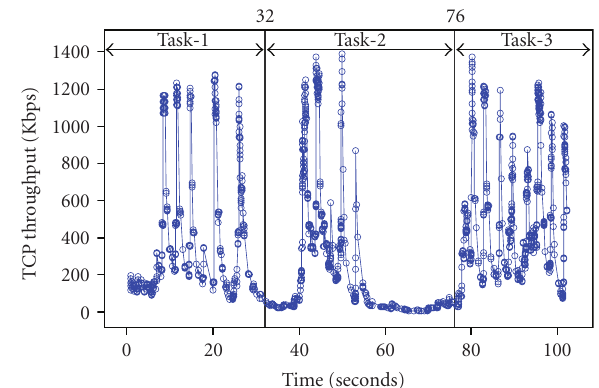
Figure 10: Control tra ffi c ( b in ) during an expert session on direct GigE network connection.